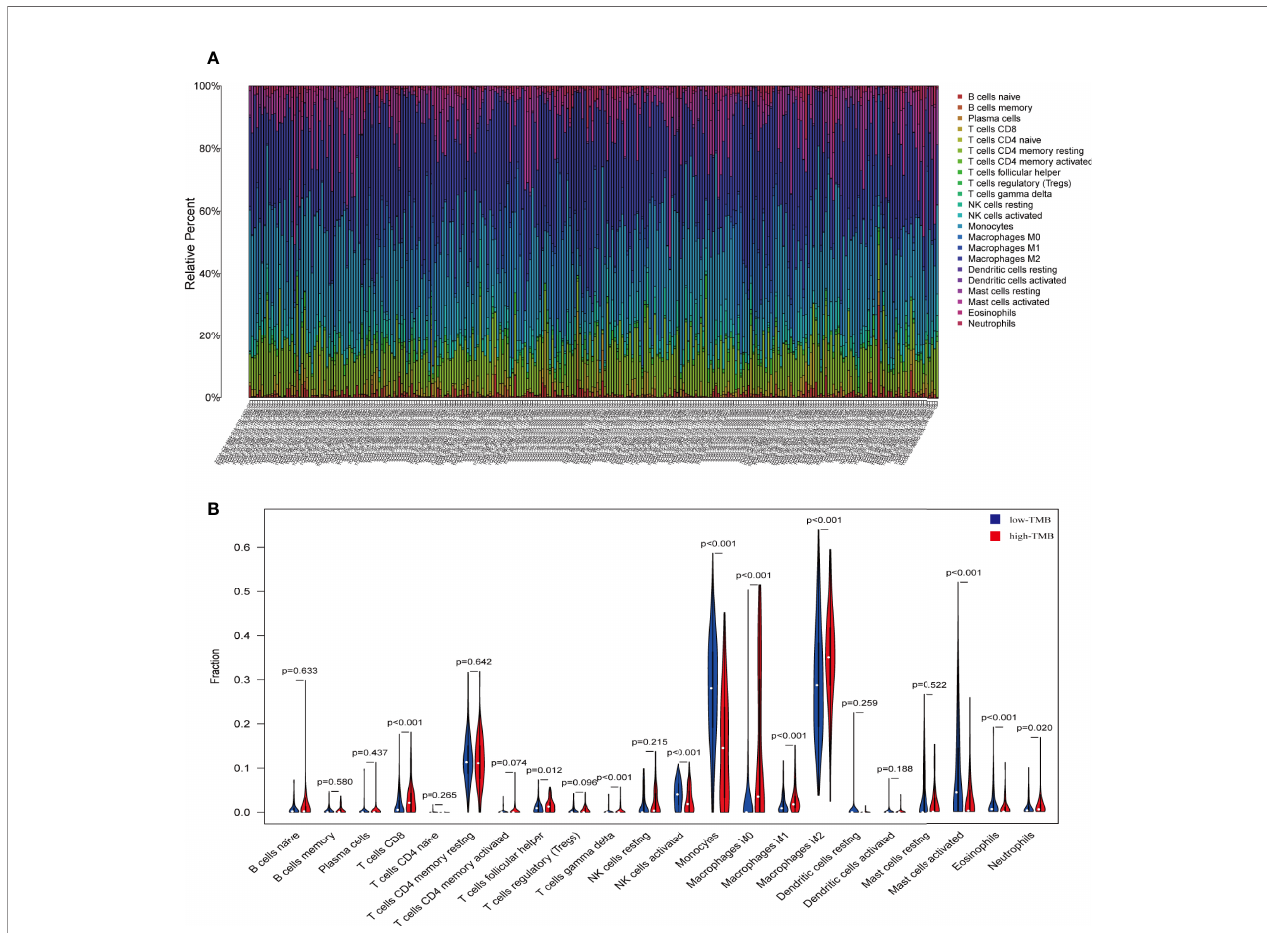
FIGURE 4 | The proportion of 22 important immune cells in low- and high-tumor mutation burden (TMB) groups. (A) The speci fi c 22 immune fractions represented by various colors in each sample are shown in a bar plot. (B) Wilcoxon rank sum test showed that the in fi ltration of CD8+T cells, helper T cells, g d T cells (T cells gamma delta), M0, M1, M2, and neutrophils was greater in the high-TMB group than in the low-TMB group. Activated NK cells, monocytes, and activated mast cells were higher in the low-TMB group than in the high-TMB group. Red: high-TMB, blue: